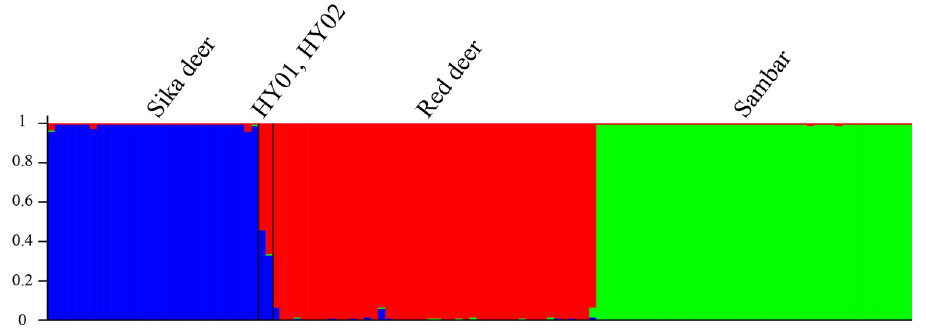
Fig 3. Assignment test in STRUCTURE for 123 deer samples based on 16 EST-SSR